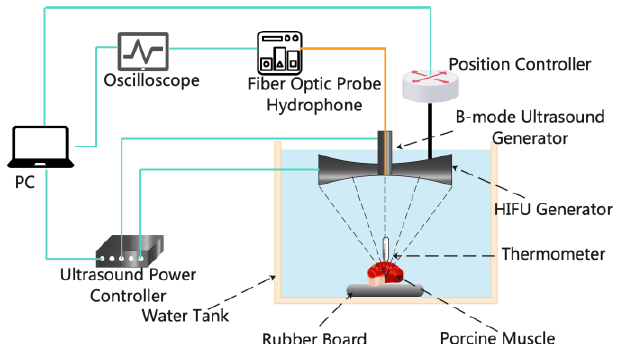
Figure 3. Ultrasonic scattered echo monitoring system during HIFU treatment.